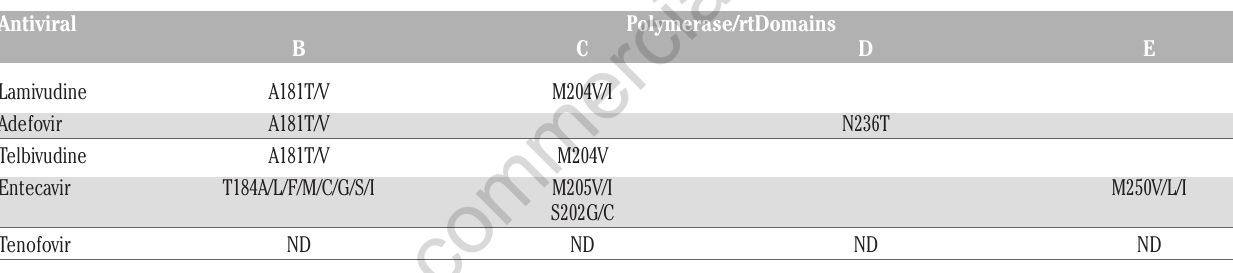
Table 1. Amino-acid substitutions in the polymerase/rtregion of HBV that confer resistance or cross-resistance to nucleos(t)ide ana- logues. ND= none demonstrated. Antiviral